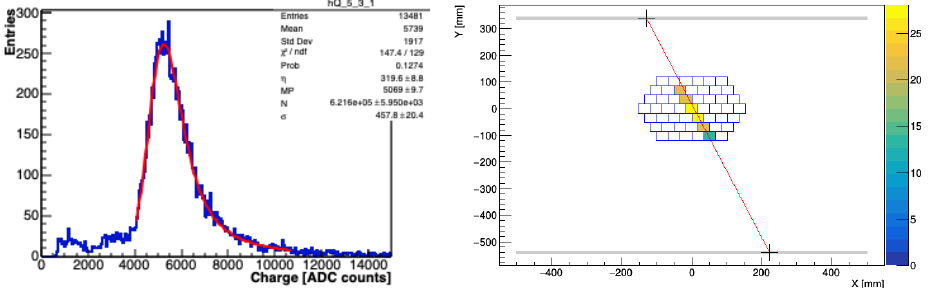
Figure 11. Example of MIP deposits in a crystal during VST with superimposed Landau–Gauss convolution fit ( left ). Example of MIP track reconstructed in the crystal matrix plane ( right ); colour scale represents energy deposit in MeV.